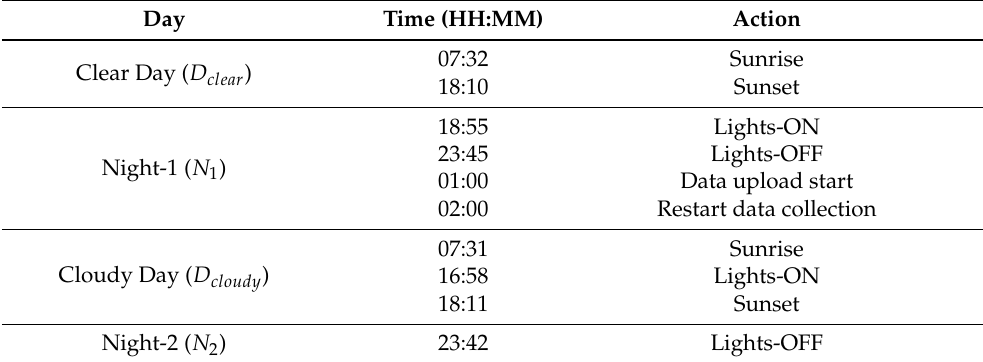
Table 4. The ambient light tracking